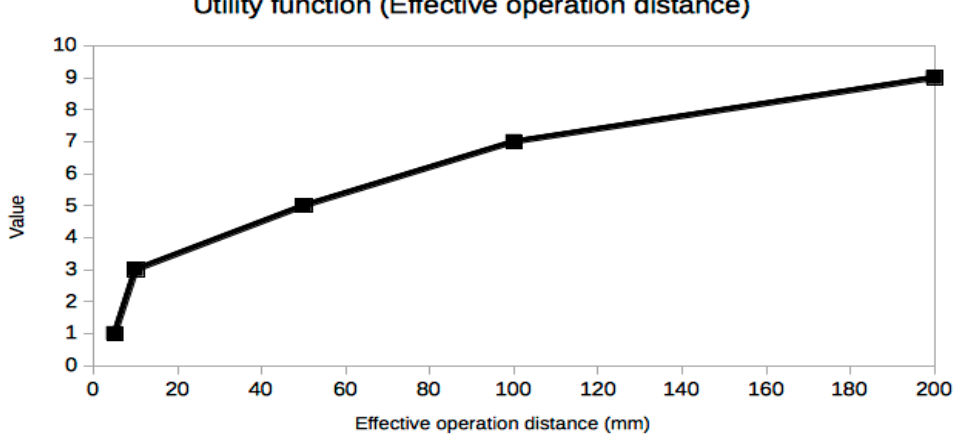
Figure 7. Utility function for Effective Operation Distance.